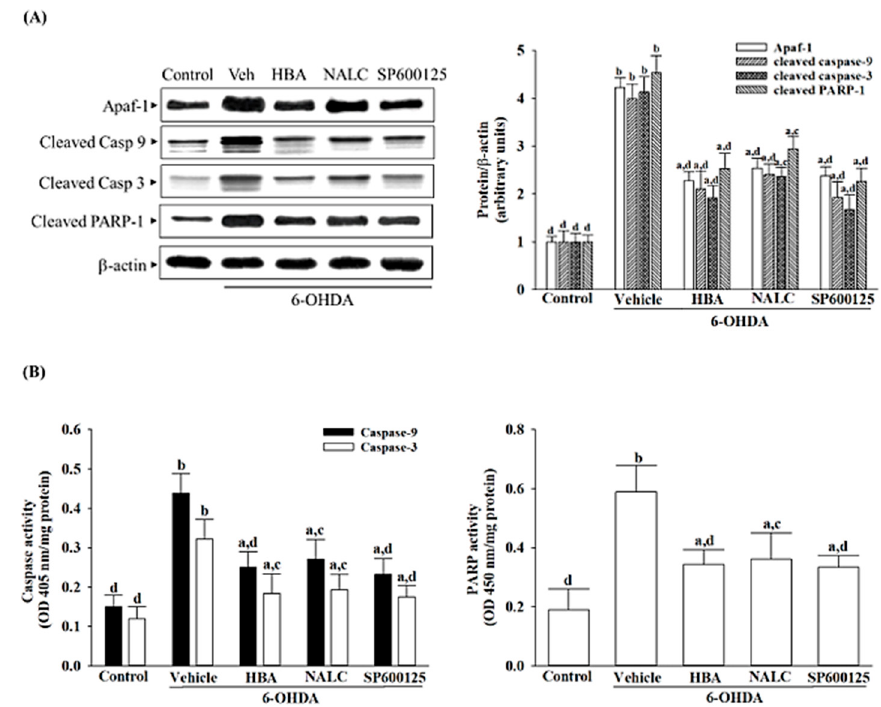
Figure 4. HBA reduces mitochondrial Apaf-1/caspase-9 pathway-mediated caspase-3 activation in- duced by 6-OHDA. SH-SY5Y cells were pretreated with HBA (120 μ mol/L), NALC (1 mmol/L),